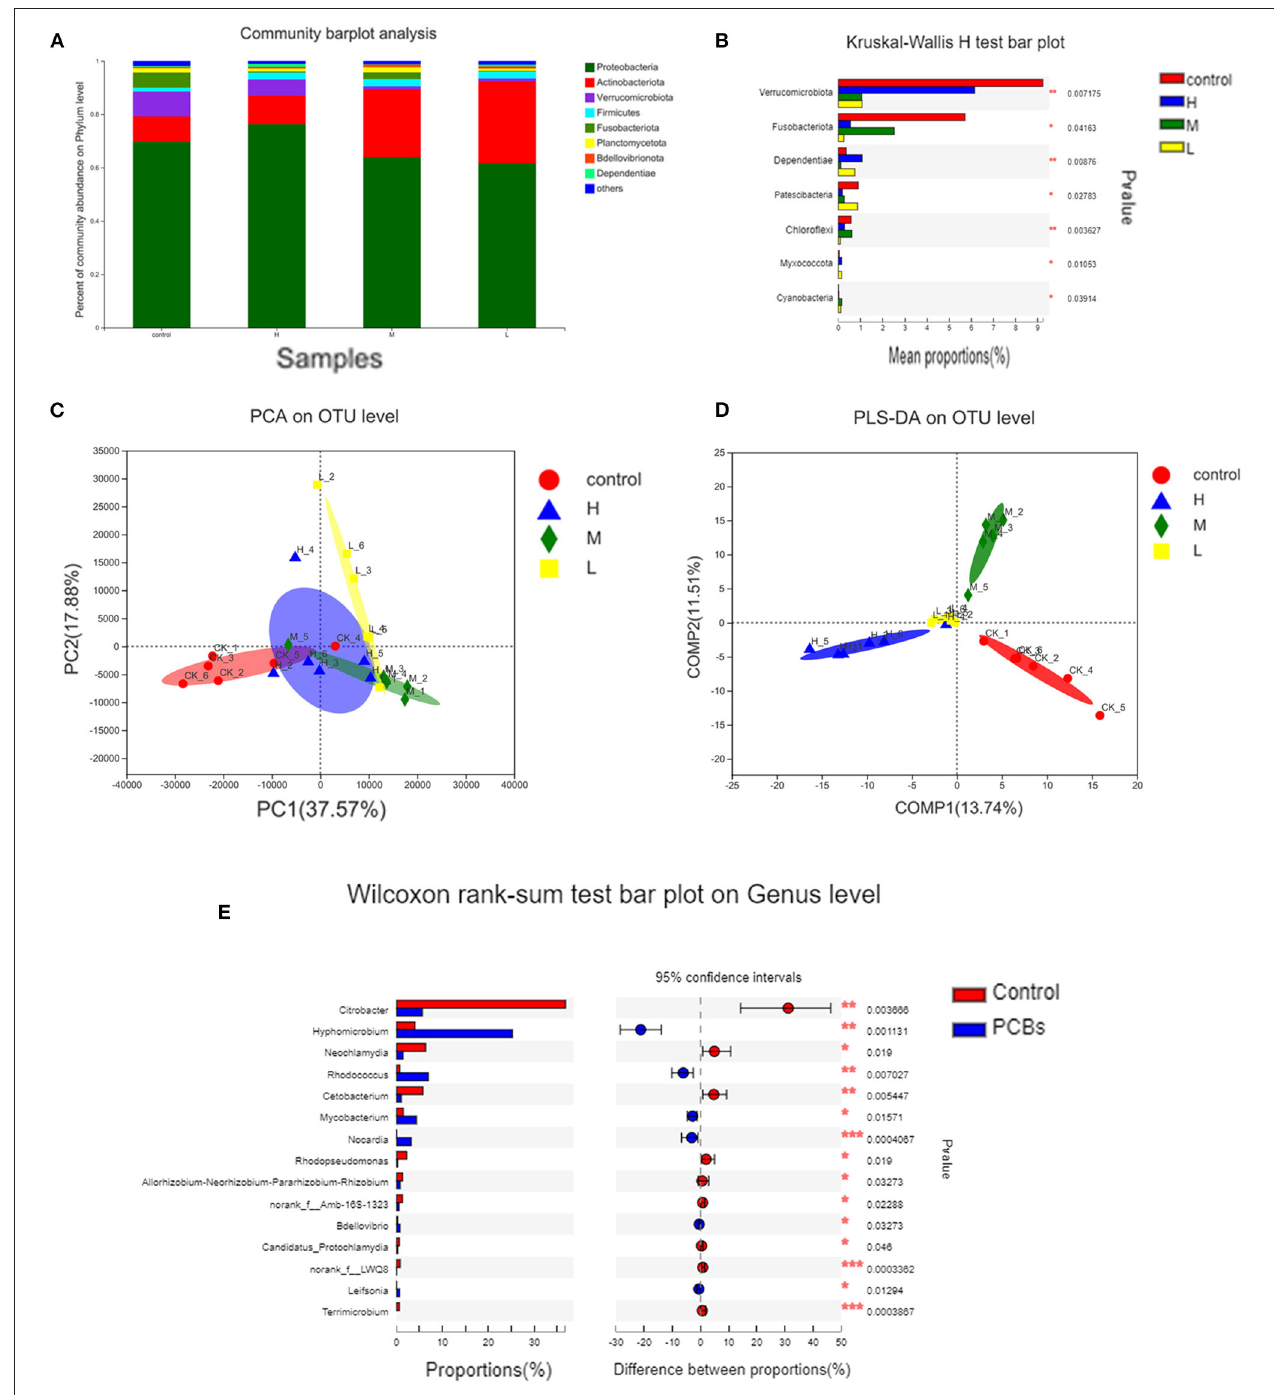
FIGURE 5 | Analysis of intestinal microorganisms of zebrafish treated with different doses of PCBs [ (A) . The microbial composition of each dose group (B) . The difference in composition of each dose group was analyzed by (C) . PCA analysis (D) . PLS-DA analysis (E) . The difference in genus level between the control group and the experimental